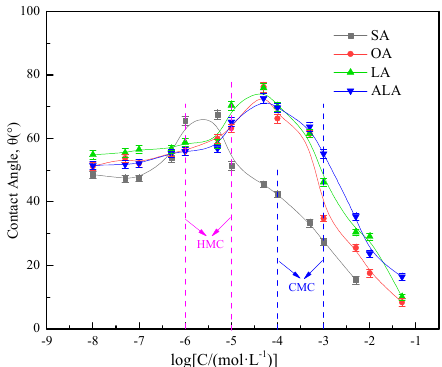
Figure 5. Variation of θ with fatty acids